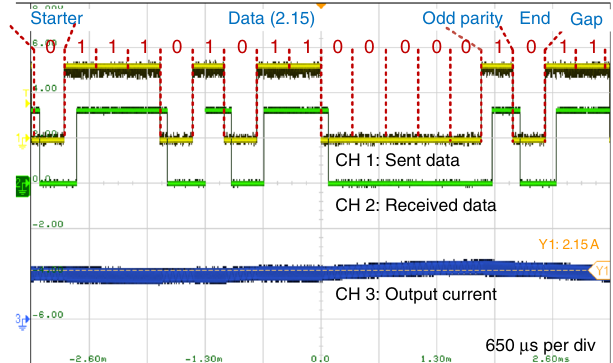
Fig. 8 Experimental results for a sent and received output current value.